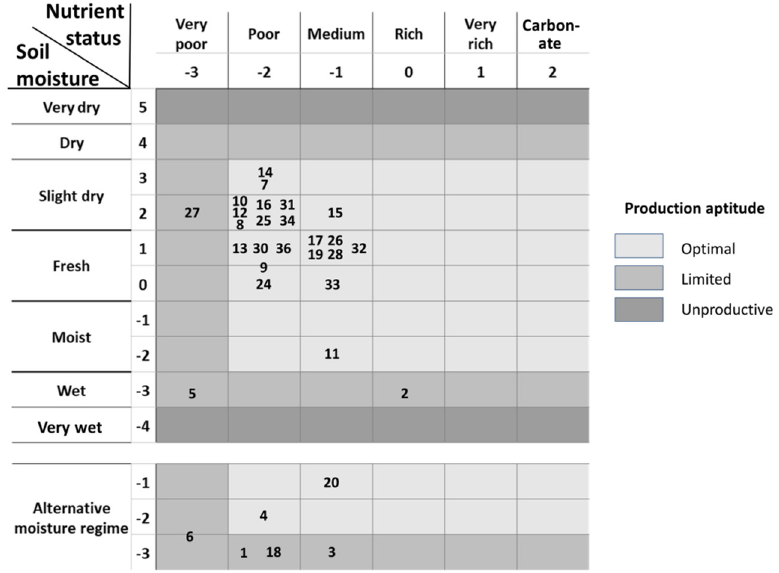
Figure 2. Soil nutrient and moisture levels of the sampled plots (site number) and birch production aptitude (cell color) based on the Afforestation Guide of Wallonia [31]. Table 1. Description of the monitoring period, silvicultural treatment (age of first crown release) and ecological condi- tions of each plot. For each plot is also given the final number of monitored target trees together with the mean, minimum and maximum dbh at the last measurement. In cases of heart decay, the number of tree rings could not be counted and so tree age could not be estimated.